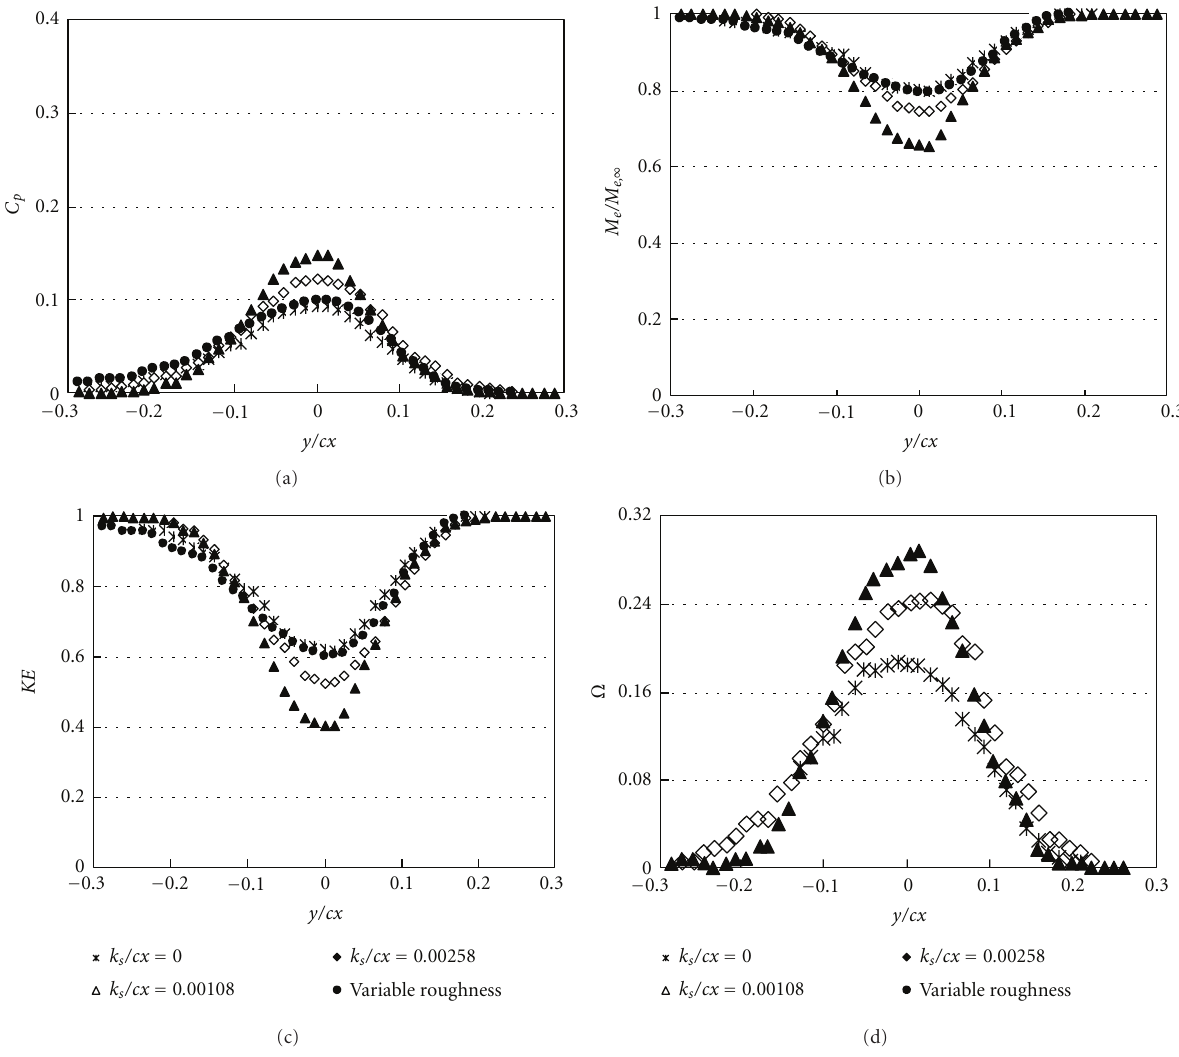
Figure 15: Profiles measured at one axial chord length downstream of the cambered vane for M ex = 0 . 71 [38]. (a) Normalized local total pressure losses. (b) Normalized local Mach numbers. (c) Normalized local kinetic energy. (d) Ω total pressure loss coe ffi cient.